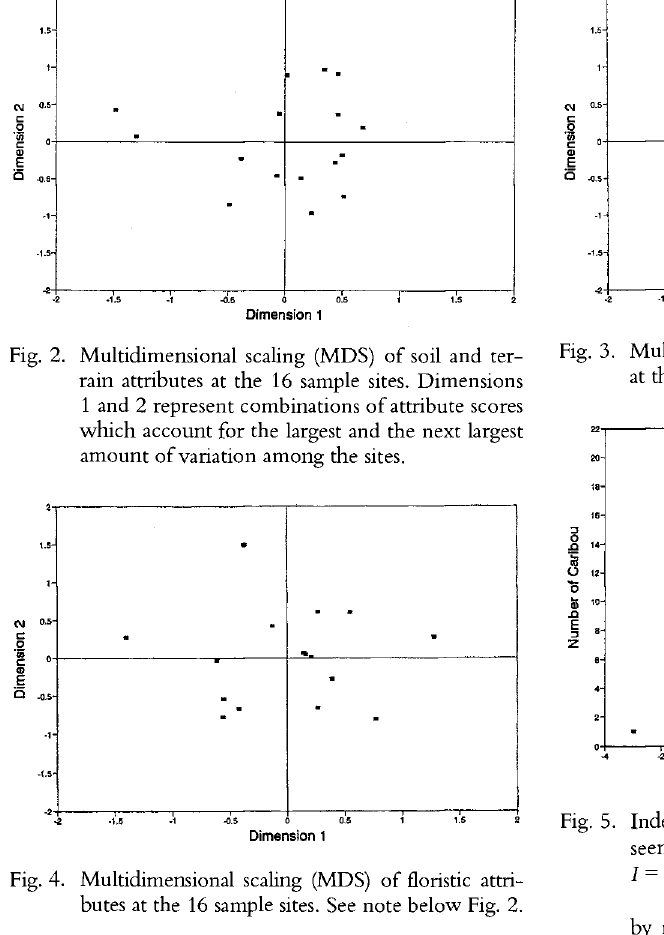
Fig. 4. Multidimensional scaling (MDS) of floristic attri butes at the 16 sample sites. See note below Fig. 2.